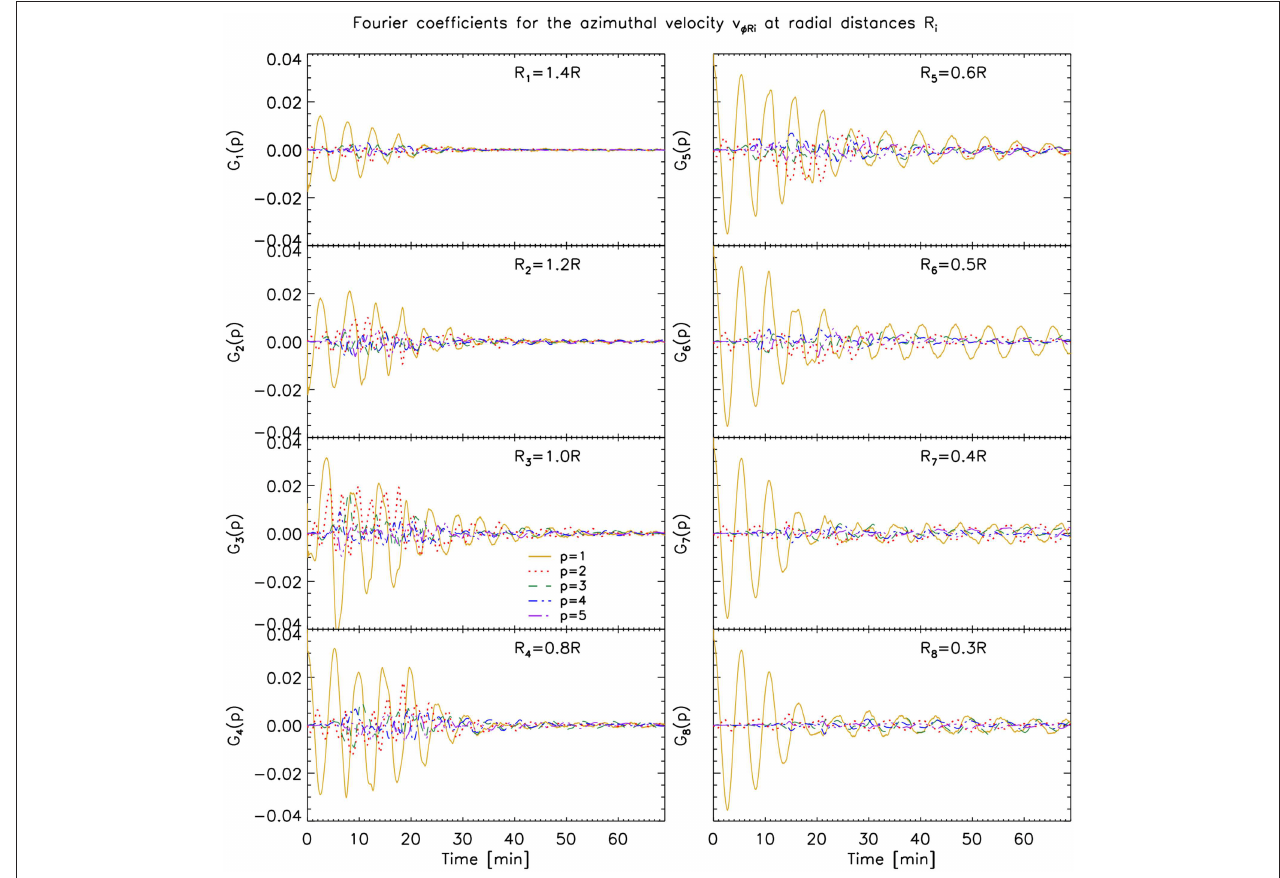
FIGURE 9 | Fourier coefficients for the azimuthal velocity v φ R more